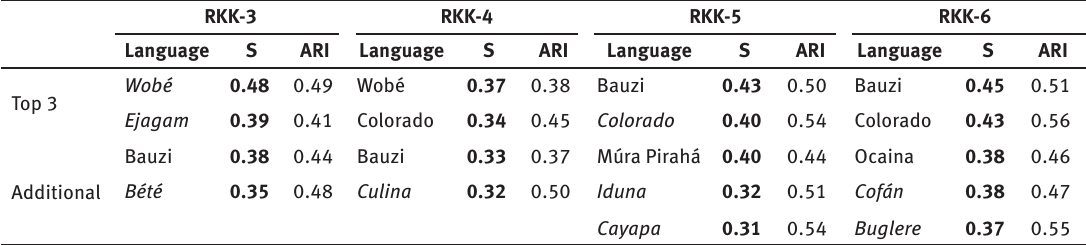
Table 2: Similarities between RKK results and some languages in the WCS. RKK-3 RKK-4 RKK-5 RKK-6